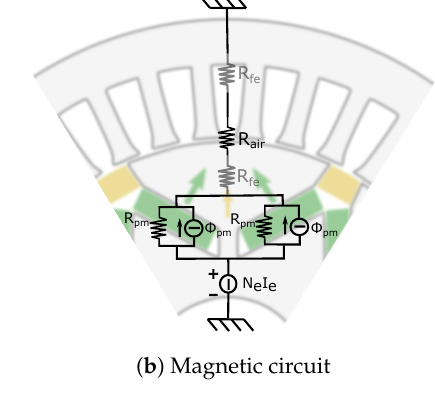
Figure 3. SRC-6 configuration: geometry and magnetic circuit.